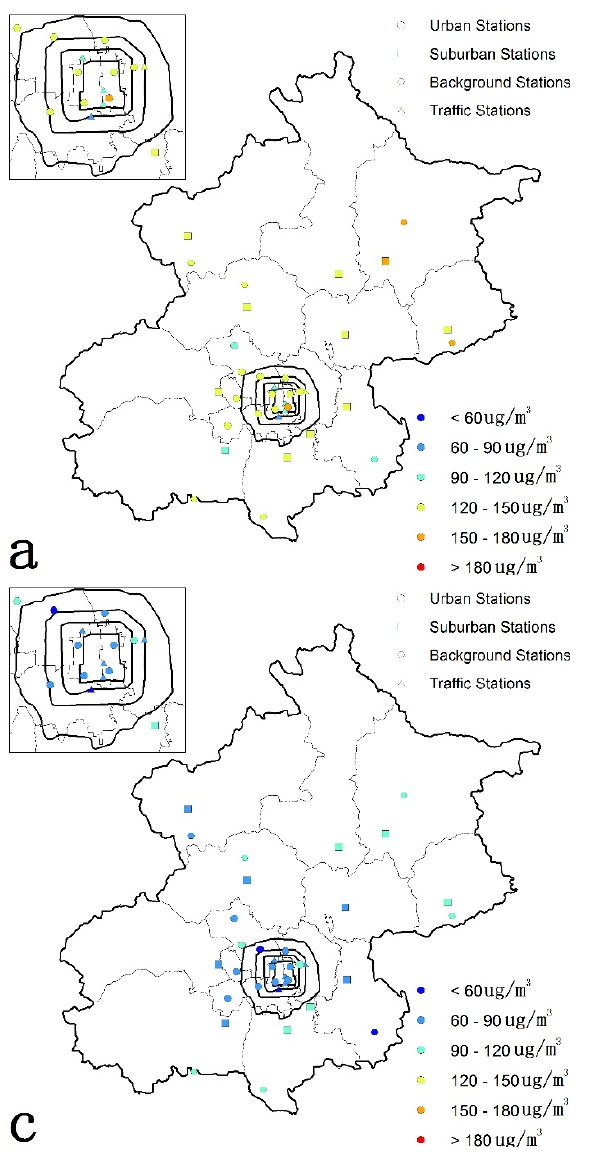
Figure 8. Seasonal variations of O 3 concentrations for the 35 air quality monitoring stations (( a ) spring; ( b ) summer; ( c ) autumn; ( d )